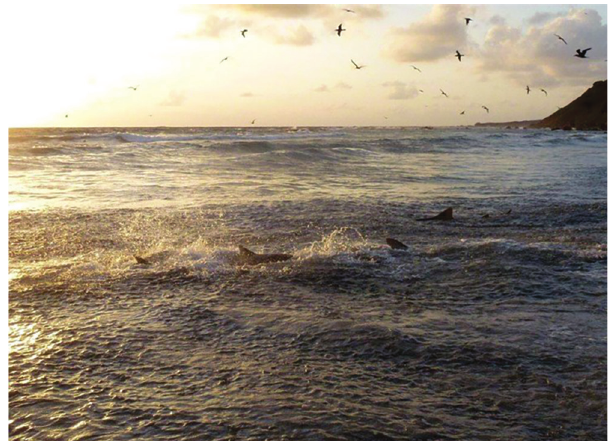
Fig. 5. Three Negaprion brevirostris (TL > 2 m) chasing schools of sardines in waters of the swash zone (0.2-0.5 m depth) during sunrise hours in site 4 in January 2013, and boobies, Sula leucogaster , and black noddies, Anous minutus , in feeding activity (Photograph by Leonardo